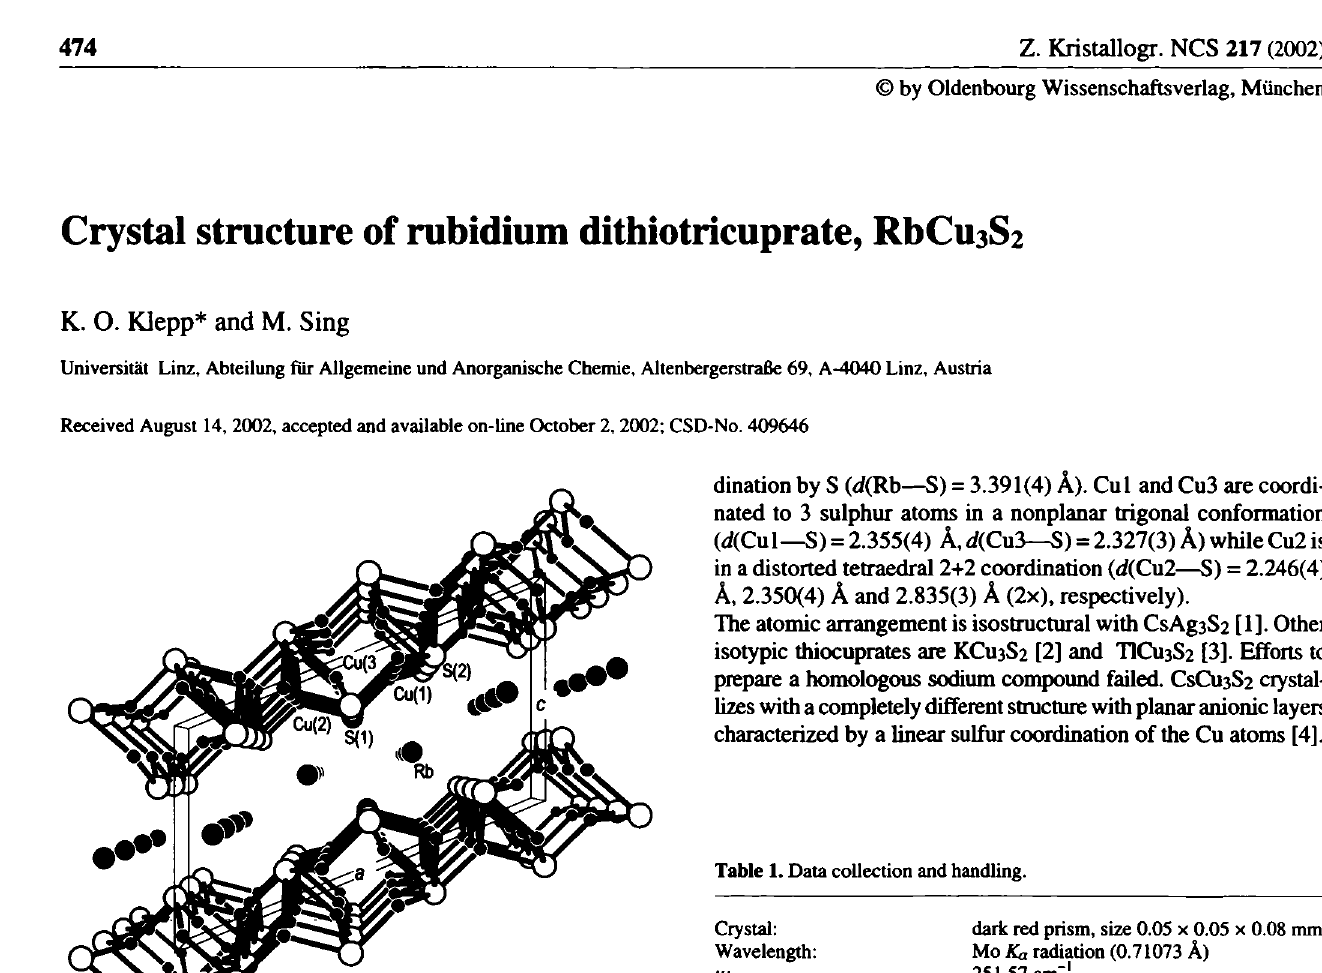
Table 1. Data collection and